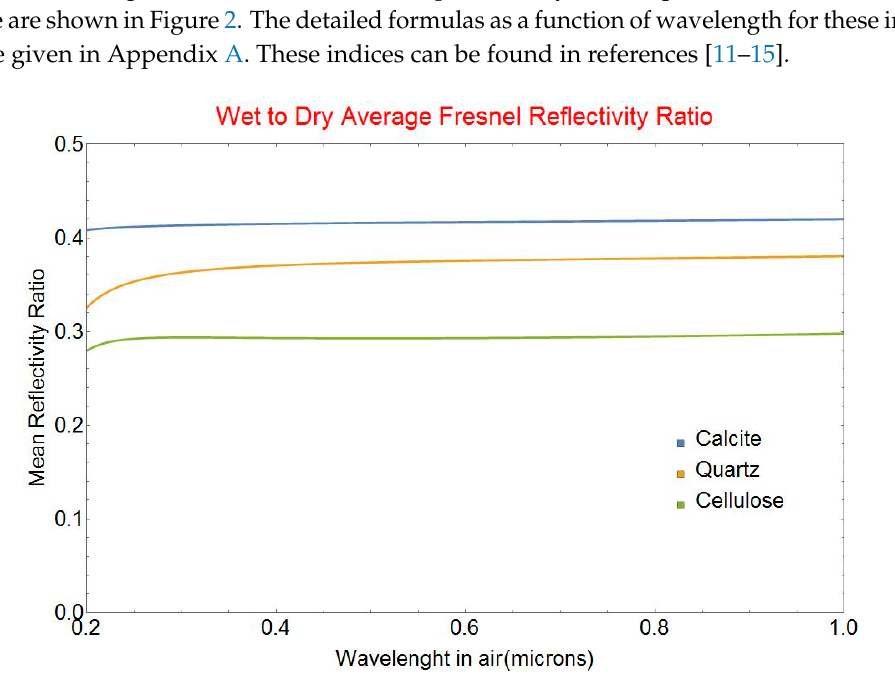
Figure 2. Wet to dry angularly averaged Fresnel reflectivity factors as a function of wavelength for important components of materials and vegetation: crystalline quartz, calcite and cellulose.